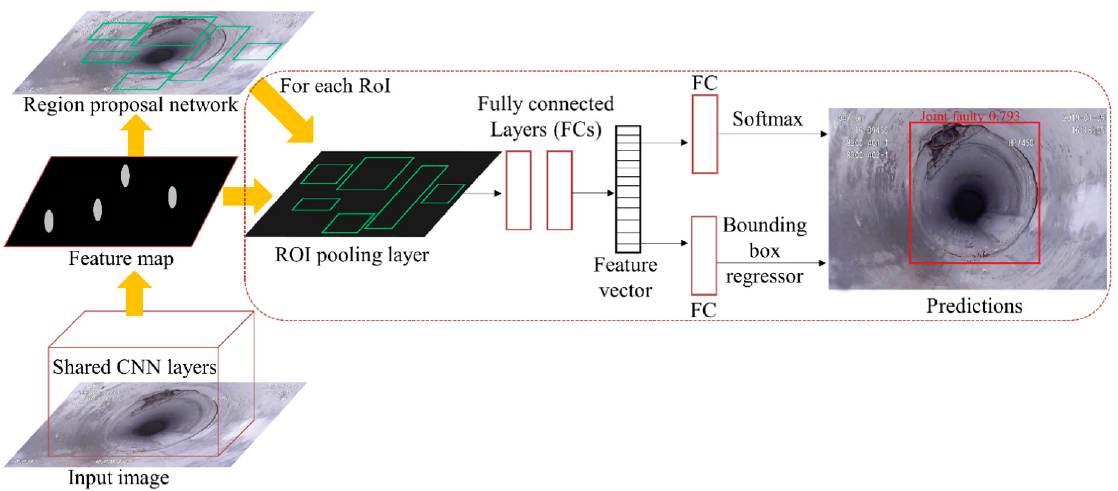
Figure 10. An architecture of the faster R-CNN developed for defect detection. ‘CNN’ refers to convolutional neural network. ‘ROI’ means region of interest. ‘FC’ is fully connected layer. In [98], 3000 CCTV images were fed into the faster R-CNN model, and the trained model was then utilized to detect four categories of defects. This research indicated that the data size, training scheme, network structure, and hyper-parameter are important impact factors for the final detection accuracy. The results show the modified model achieved a high mAP of 83%, which was 3.2% higher than the original model. In another work [99], a defect tracking framework was firstly built by using a faster R-CNN detector and learning discriminative features. In the defect detection process, a mAP of 77% was obtained for detecting three defects. At the same time, the metric learning model was trained to reidentify defects. Finally, the defects in CCTV videos were tracked based on detection information and learned features. Table 3. Academic studies in vision-based defect detection algorithms.